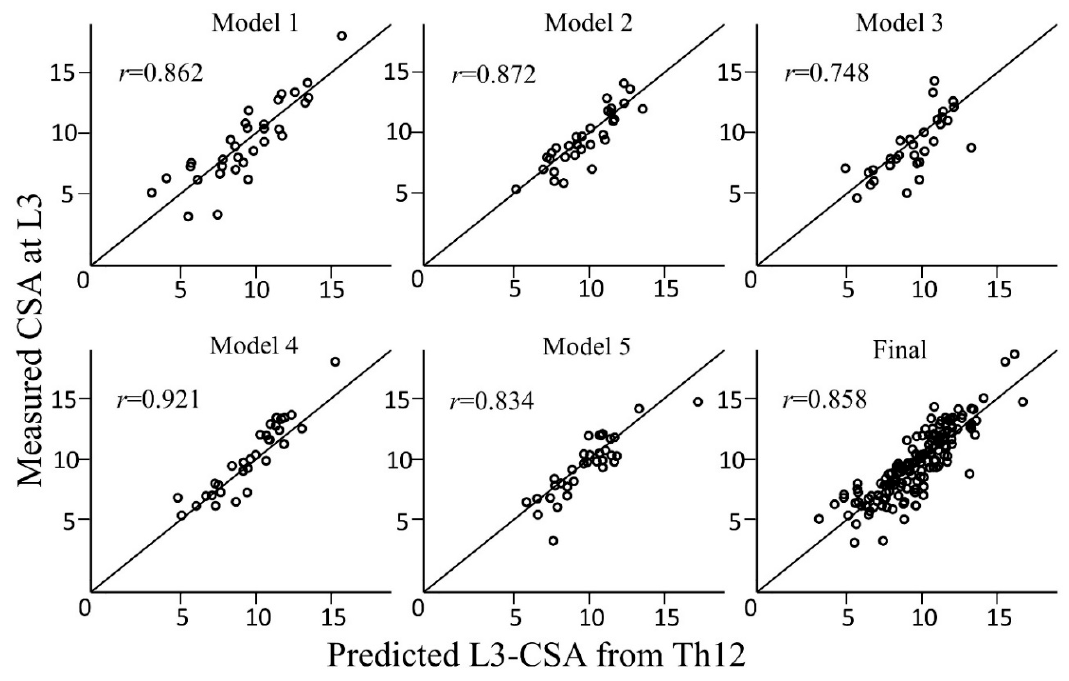
Figure 2. Scatter plot of measured cross-sectional area (CSA) of the muscles and predicted CSA of the muscles in each preliminary model and the final model.